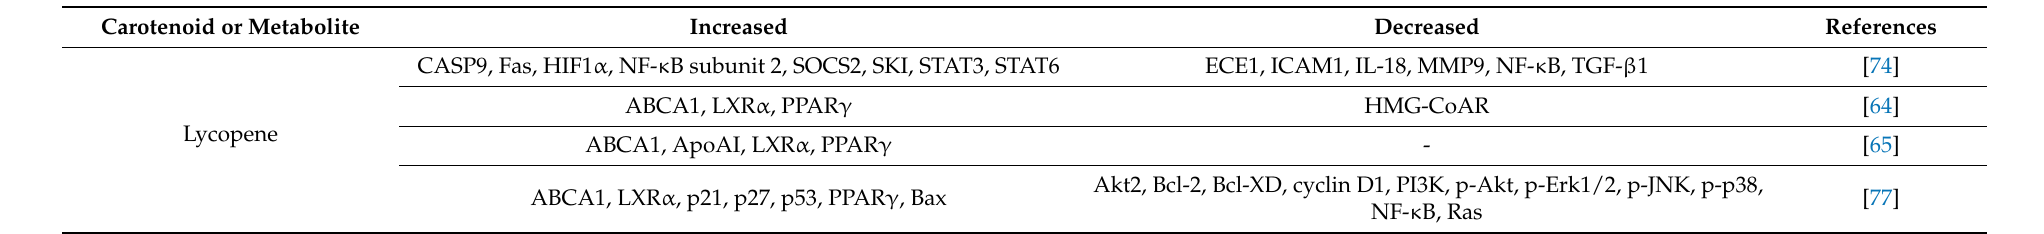
Table 4. The changes in levels of given proteins or mRNA induced by the administration of distinct carotenoids, based on cellular or animal trials. Interactions between listed factors are shown in Figure